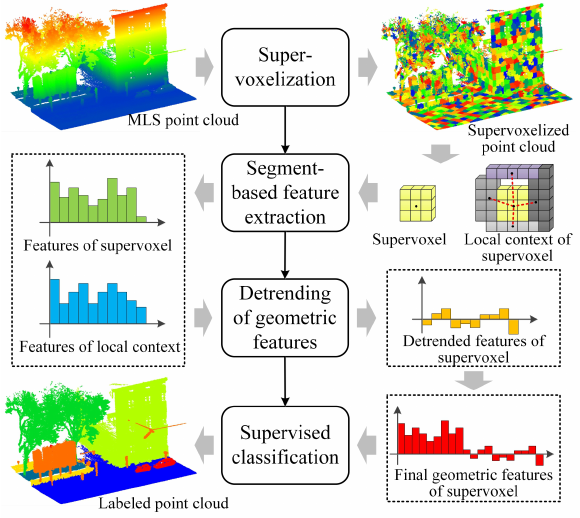
Figure 2. Workflow of our point cloud classification